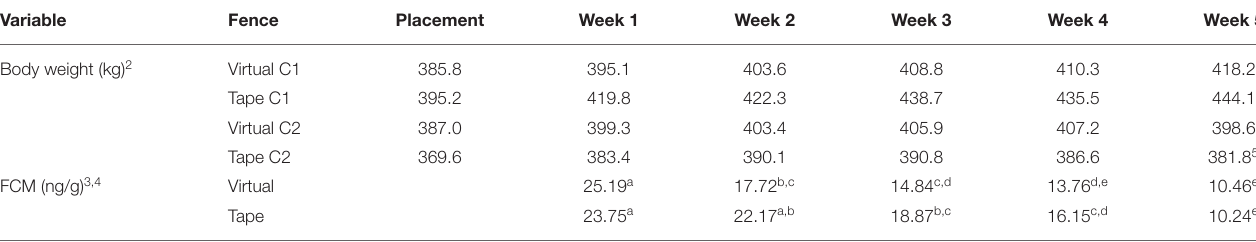
TABLE 2 | The body weight and FCM in dry feces for cattle exposed to a virtual or electric tape fence within a 5-week period across two test cohorts 1 . Variable